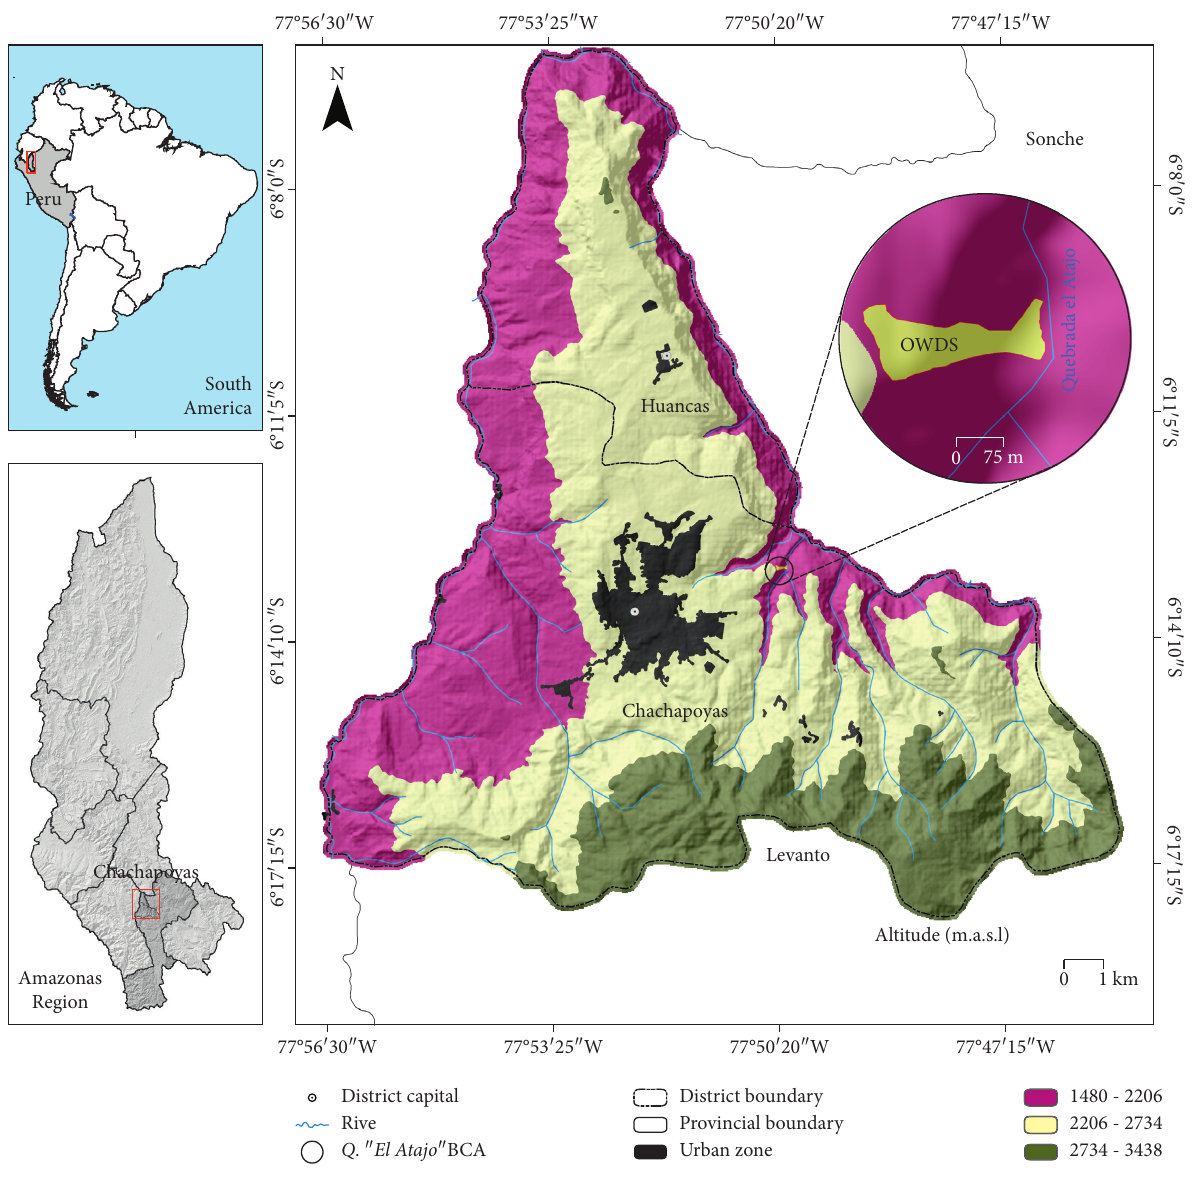
Figure 1: Location of the districts of Chachapoyas and Huancas, Amazonas, NW